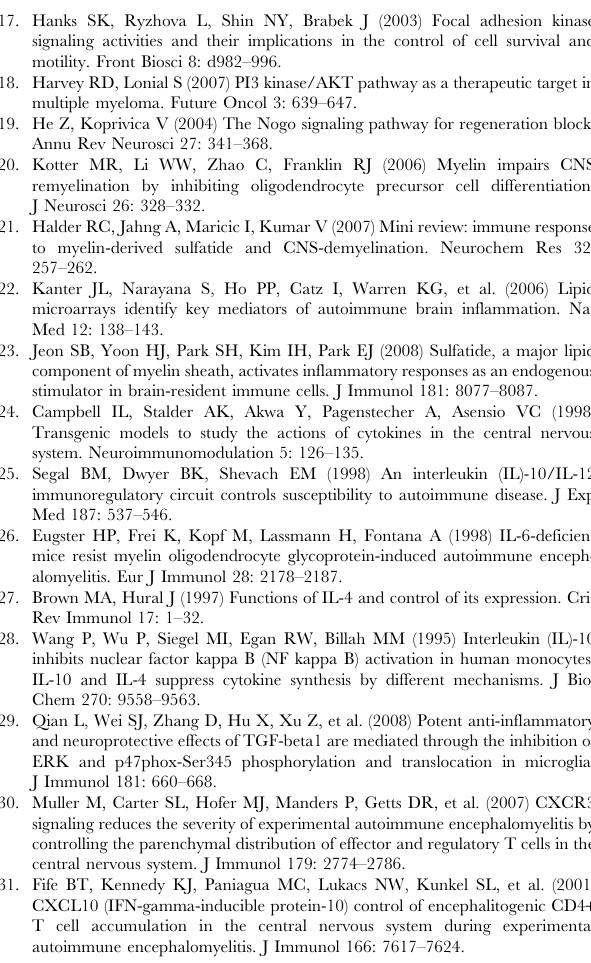
Table S1 Primer sequences for qRT-PCR Found at: doi:10.1371/journal.pone.0009380.s001 (0.04 MB